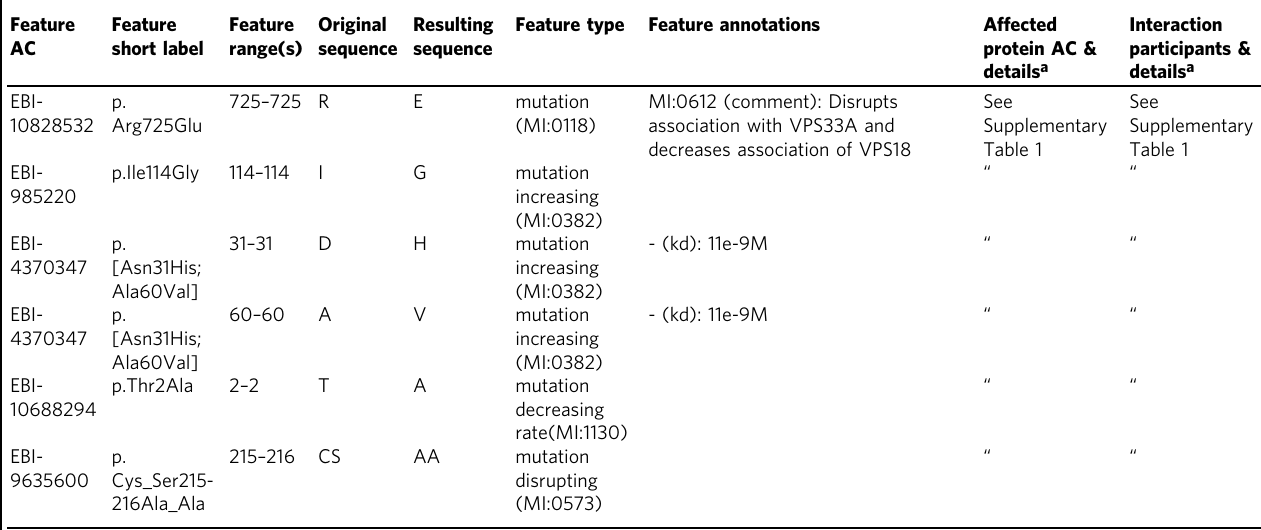
Table 1 Overview of the IMEx mutations data set downloadable fl at fi le Feature Feature AC short label